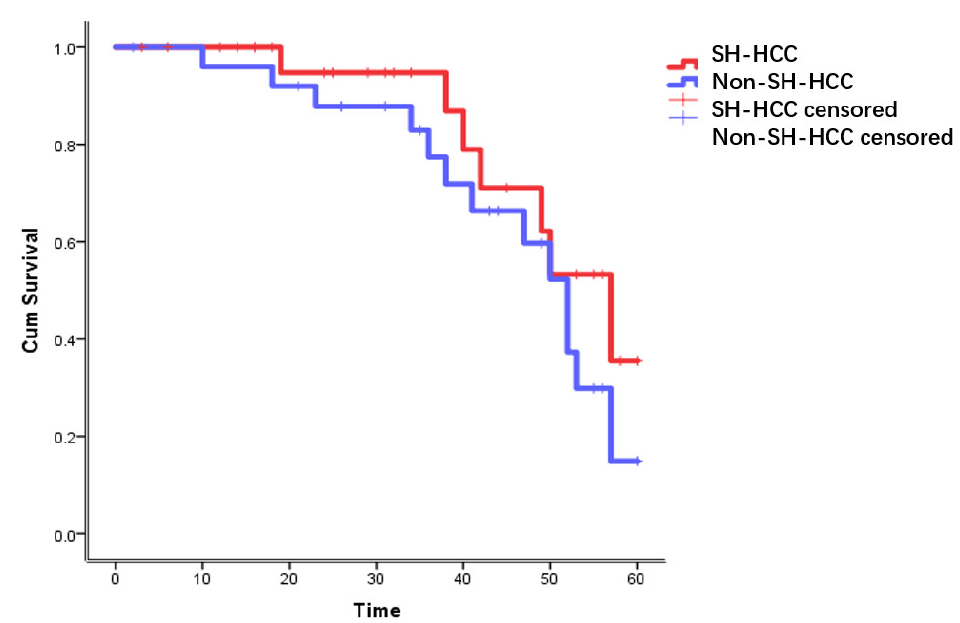
Figure 3. The survival curve of SH-HCC and non-SH-HCC patients.